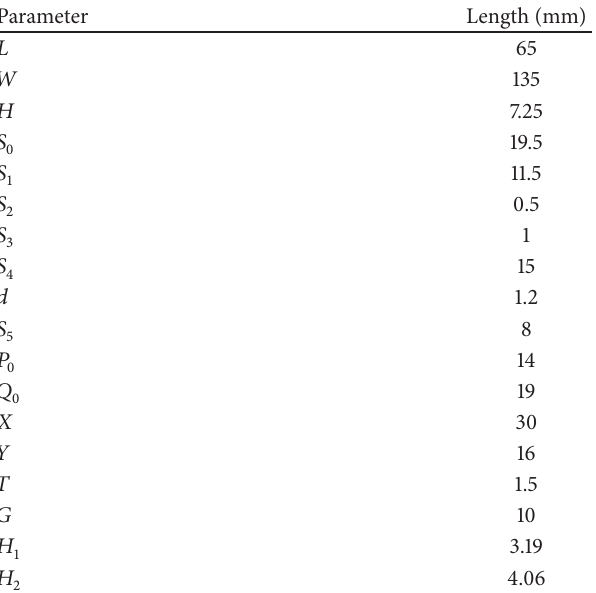
Table 1: Parameters used in the